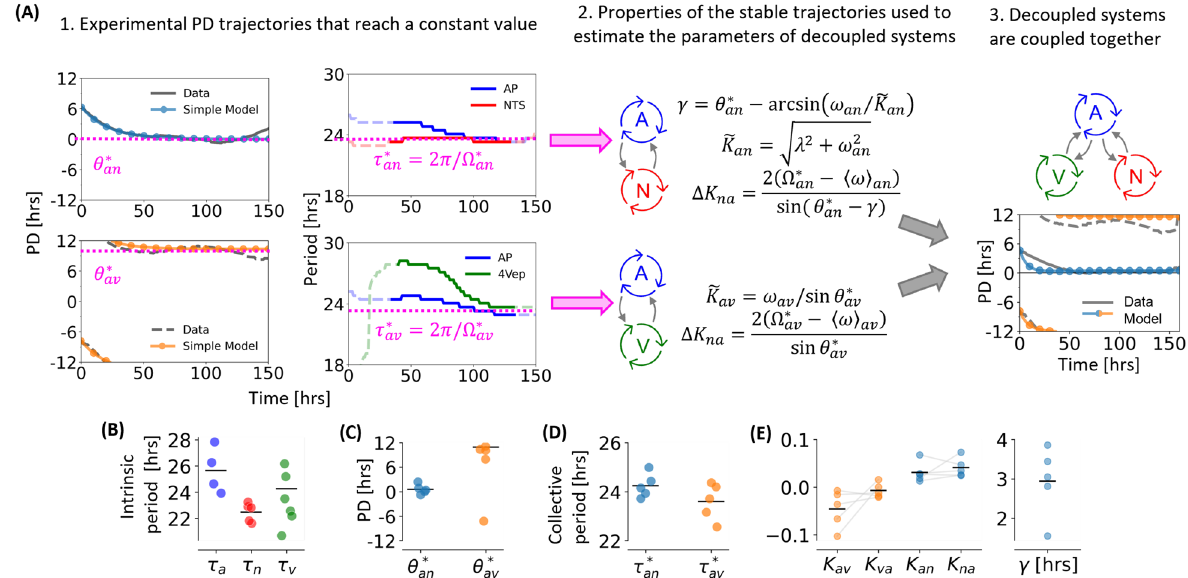
Figure 2. Estimating model parameters using the most stable PD recordings. ( A ) Constant PD trajectories can be analysed to find the steady state PD ( θ ∗ ij ) and the collective period of the two oscillators when their PD is constant ( τ ∗ ij ), which is used to estimate the parameters of two two-oscillator models. Recoupling the two systems creates a three-oscillator model that closely matches the data. ( B ) Intrinsic period parameters. Note that τ a and τ v overlap. ( C ) The constant PD between the most stable oscillator pair and ( D ) the corresponding collective periods. ( E ) The coupling parameters and AN phase lag are estimated from the most stable PD